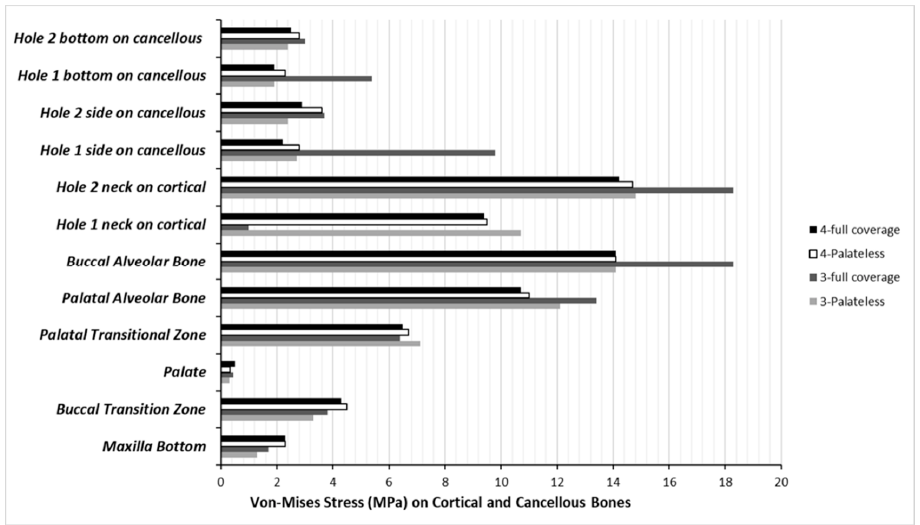
Figure 11. Results for axial loadings on three- and four-implant models with and without palatal